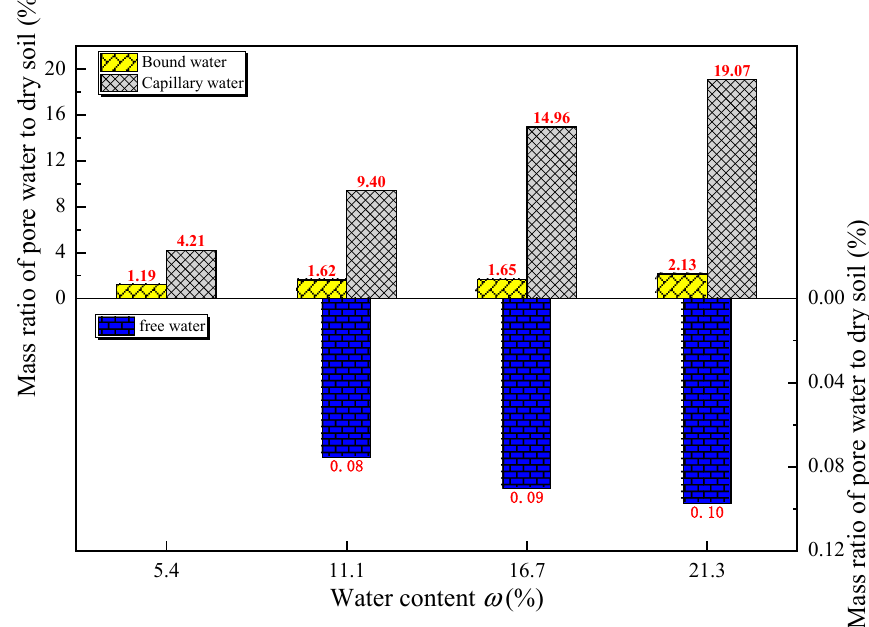
Figure 9. Variation in the mass ratio of pore water in different occurrence forms to dry soil mass with the water content of the sample. J. Mar. Sci. Eng. 2020 , 8 , x FOR PEER REVIEW